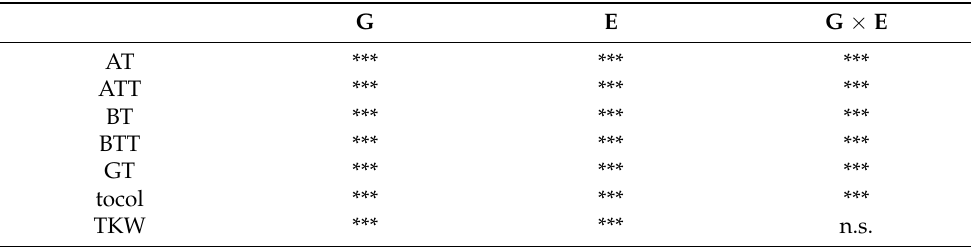
Table 2. Effect of the genotype, the environment, and their interaction with the tocol content and composition of the Mv Toborzó/Tommi lines (2014 and 2019).